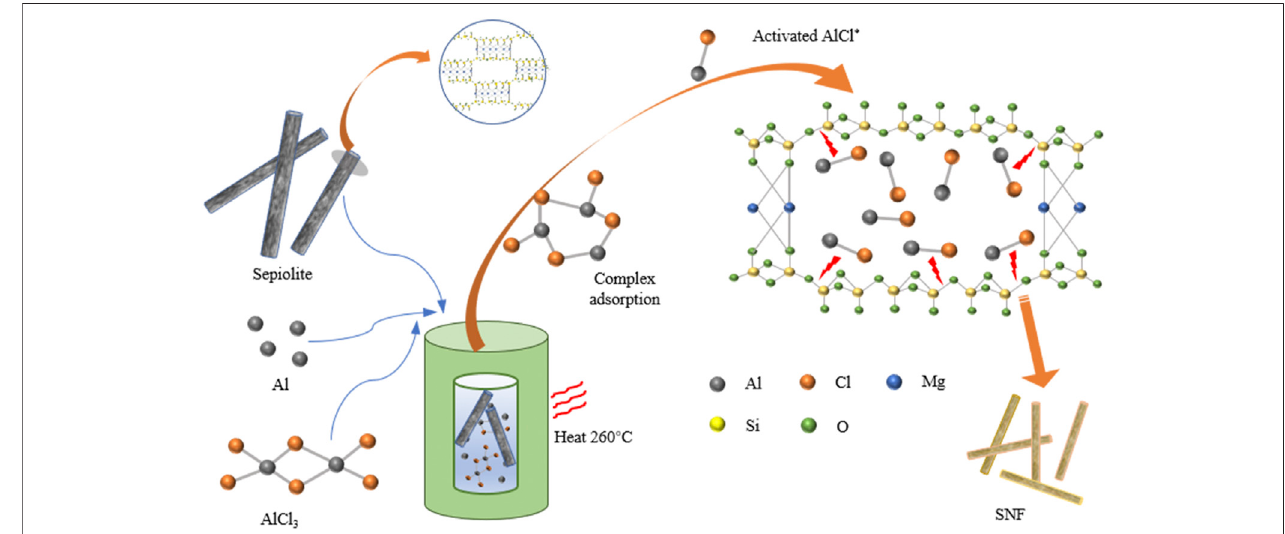
FIGURE 1 | Schematic of SNF from natural sepiolite.